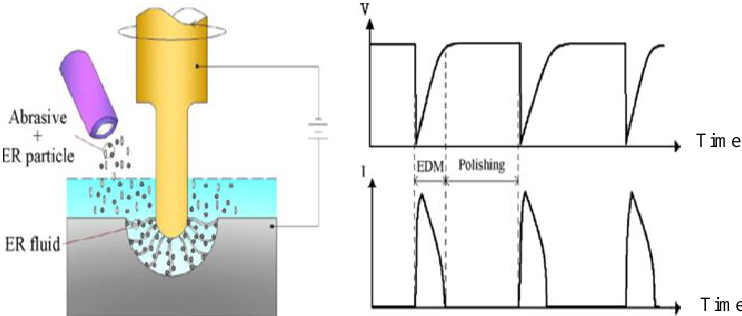
Figure 28. Schematic diagram of the proposed method using the ER fluid and abrasive grit [88].